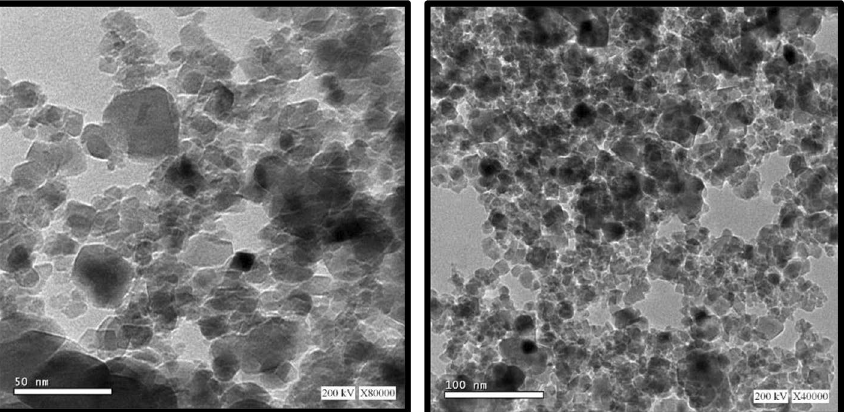
Figure 5. HRTEM of (Co/Zn) Al2O4 nano catalyst.